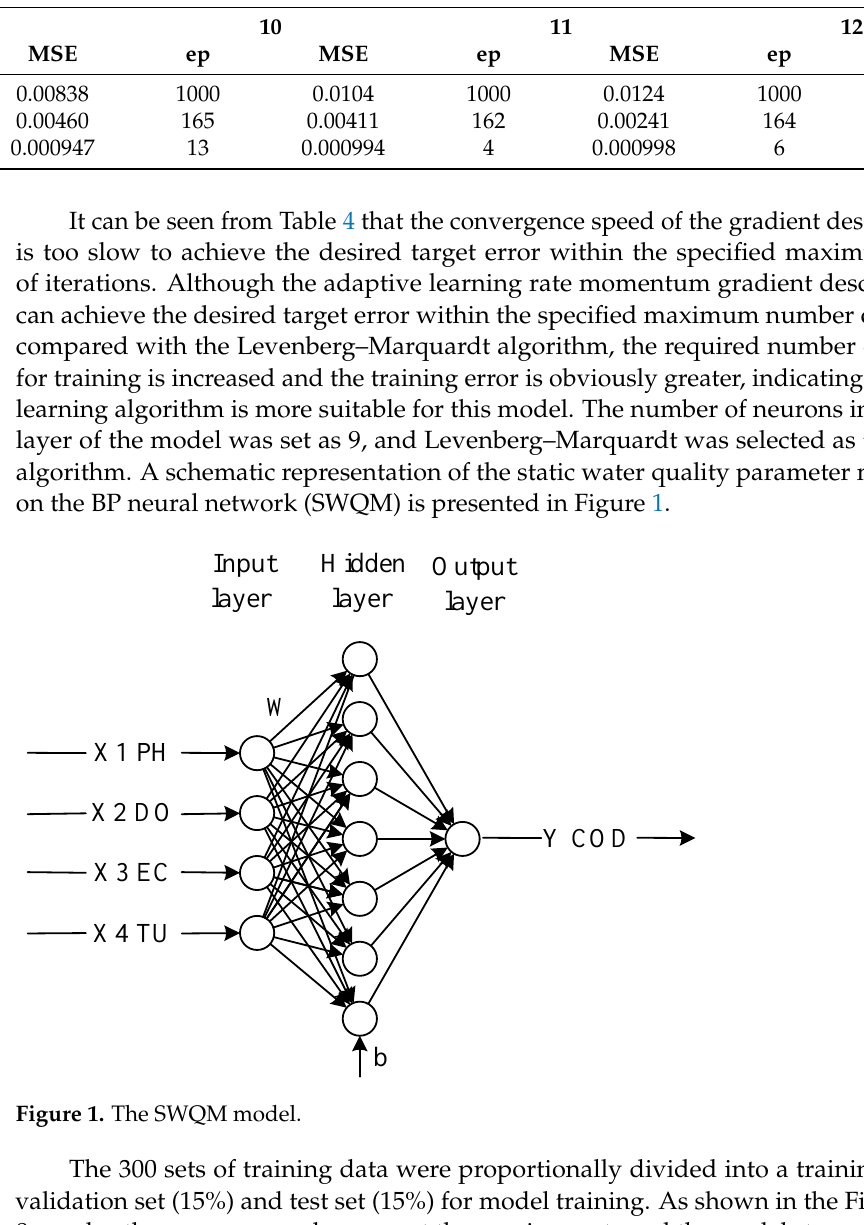
Figure 1. The SWQM Figure 1. The SWQM model.